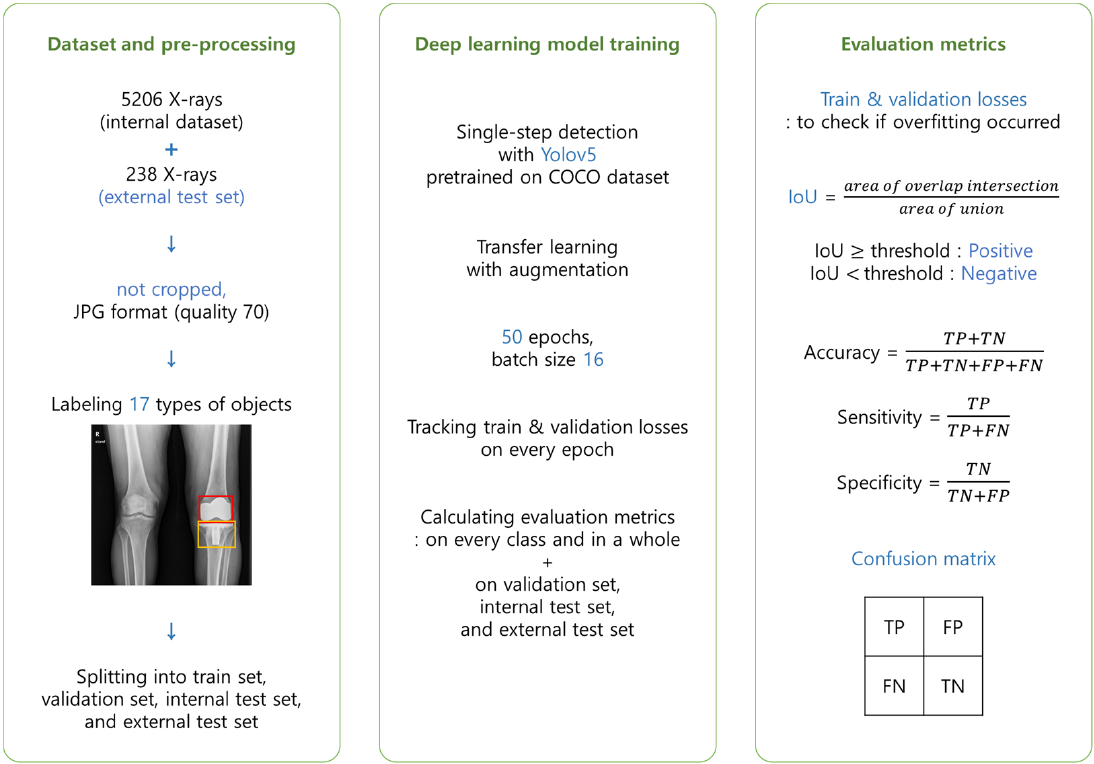
Figure 1. A schematic process of the deep learning system development in this study. (TP = true positive, TN = true negative, FP = false positive, FN = false negative, mAP = mean average precision).